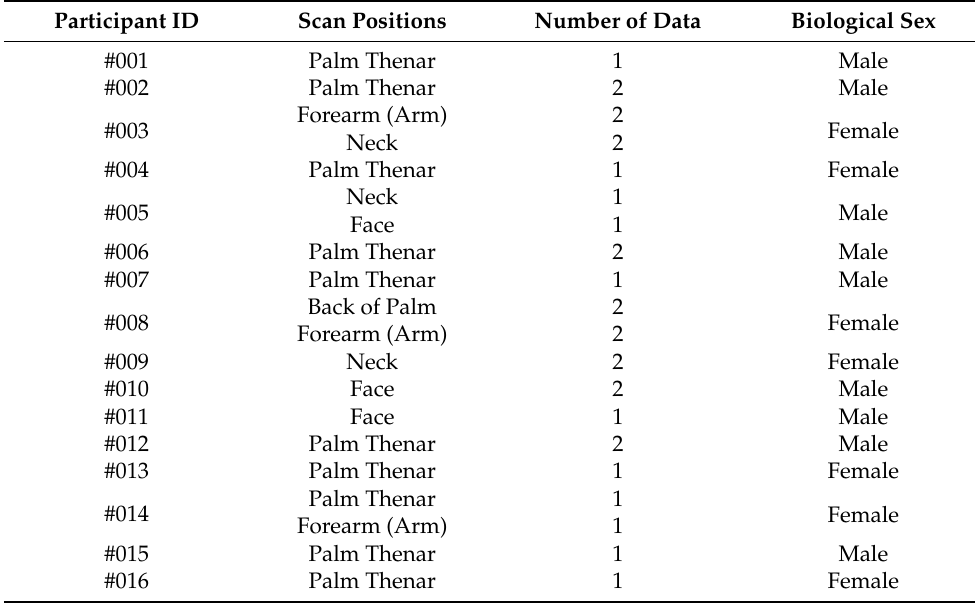
Table 1. Selected six-repeated OCT signals from the participants and relative scan